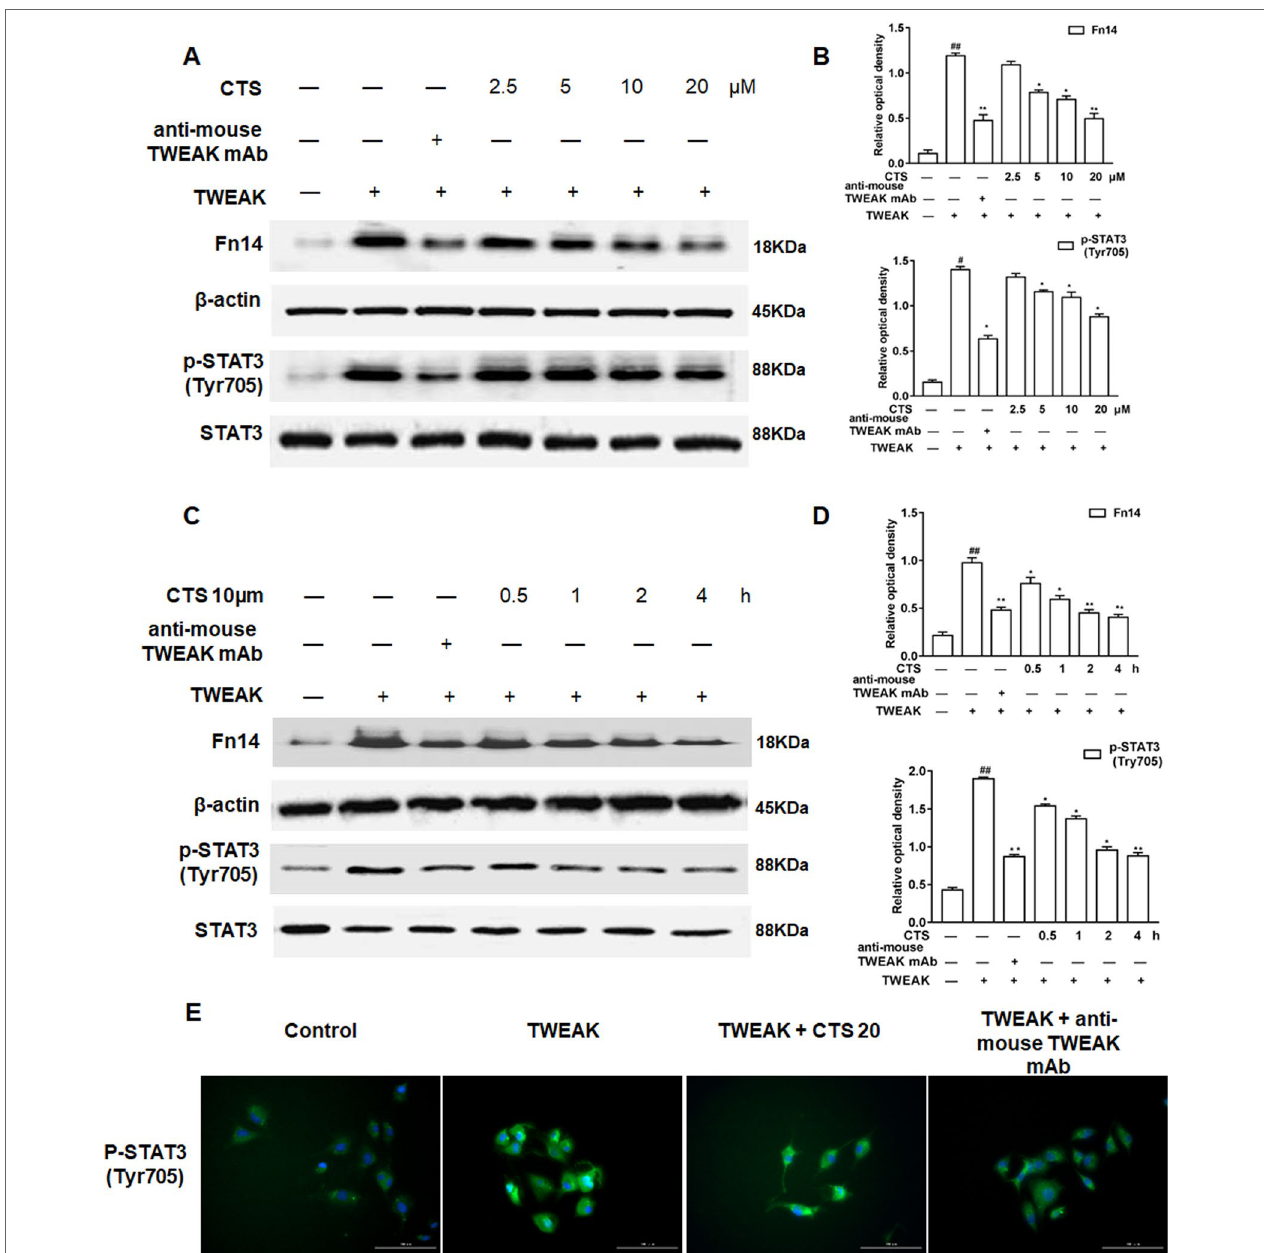
FIGURe 6 | The effect of cryptotanshinone (CTS) on the airway remodeling through tumor necrosis factor-like weak inducer of apoptosis (TWEAK)/STAT3 in TWEAK-induced airway smooth muscle cells (ASMCs). (A) Western blot of Fn14, p-STAT3 (Tyr705), and STAT3 in response to the treatment with anti-TWEAK mAB or different doses of CTS in ASMCs. (C) Western blot of Fn14, p-STAT3 (Tyr705), and STAT3 under the treatment with anti-TWEAK mAB or 10 μM CTS at different time in ASMCs. (B and D) Densitometric analysis was presented as the relative ratio of each molecule to Smad2/3, β-actin, and STAT3. Data were presented as mean ± SEM (n = 3). #P < 0.05, ##P < 0.01 vs. untreated group; *P < 0.05, **P < 0.01 vs. TWEAK-induced group. (e) The immunofluorescence analysis of p-STAT3 (Tyr705) in ASMCs showed that this protein was mainly expressed in the cytoplasm of ASMCs. Magnification: 200×. As shown in the pictures, p-STAT3 (Tyr705) was stained green and nuclei was stained with 4′,6-diamidino-2-phenylindole showing a blue color.